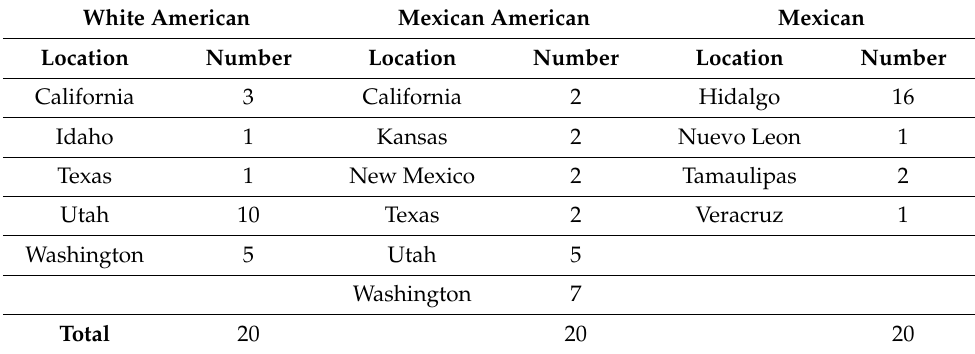
Table 1. Origin of Participants for the Three Groups.